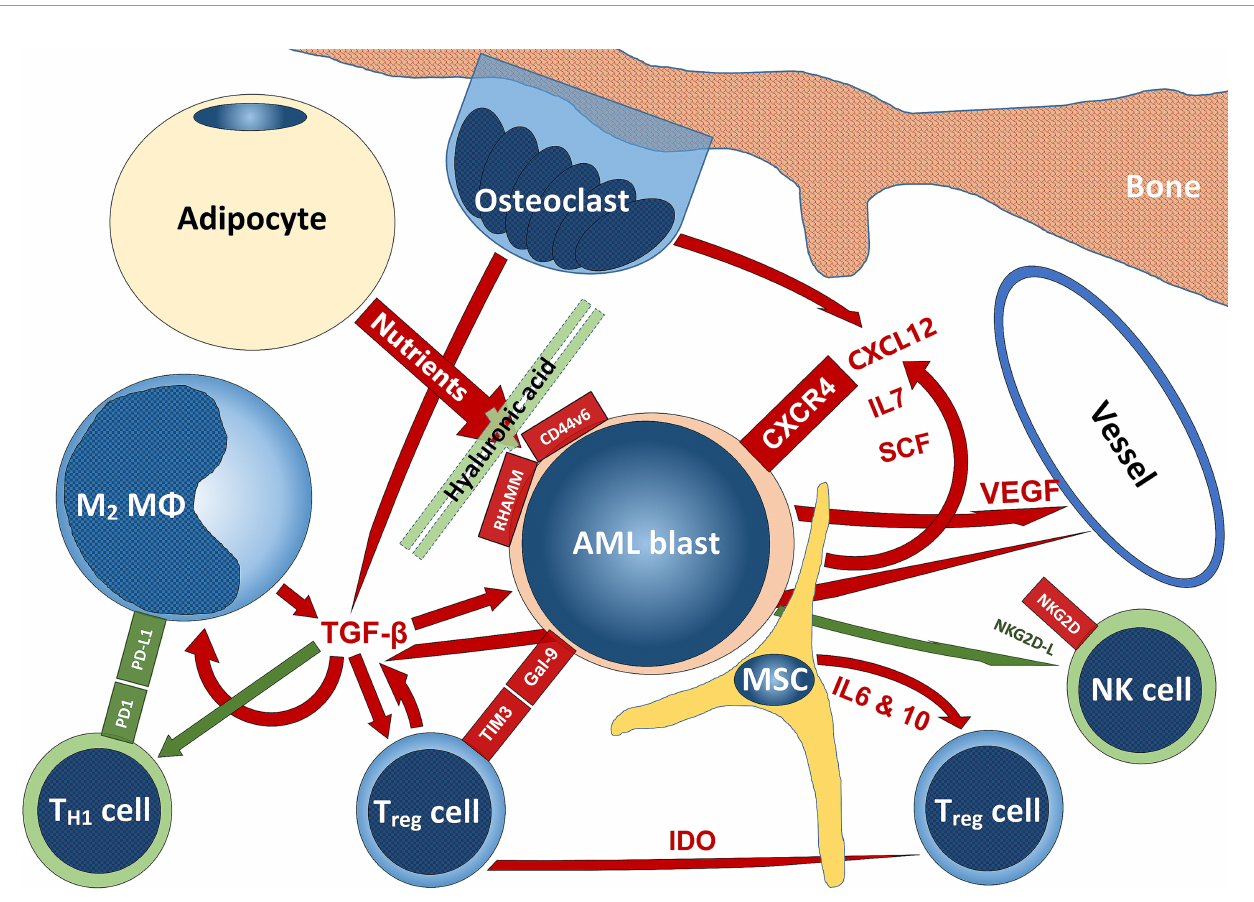
FIGURE 6 | Schematic summarizing some interactions of AML with the TME. Stimulatory signaling is delineated in red, inhibitory – in green; tumor-promoting cells are blueish, tumor-suppressing cells – greenish, while niche-cells and nutrient-supplying cells are yellowish. The scheme does not claim to be complete and